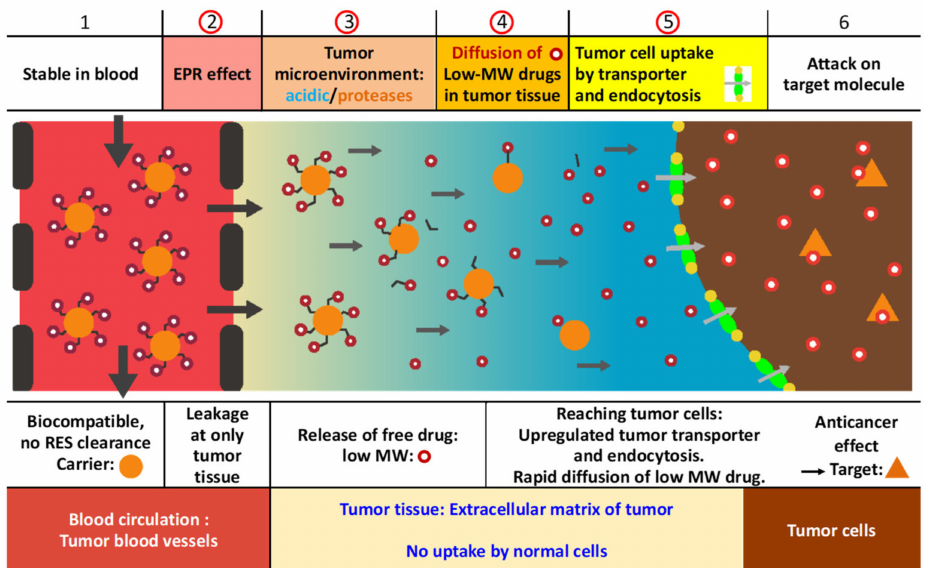
Figure 3. Multiple barriers and necessary conditions for overcoming them in nanomedicine targeting tumors. To maximize the effectiveness of nanomedicine, the following three conditions must be met: ( 1 ) Selective accumulation of the macromolecule in the tumor; ( 2 ) release of the active pharmaceutical ingredients (API) into the tumor tissue; and ( 3 ) active cellular uptake of the API into the tumor cells. Adapted from reference